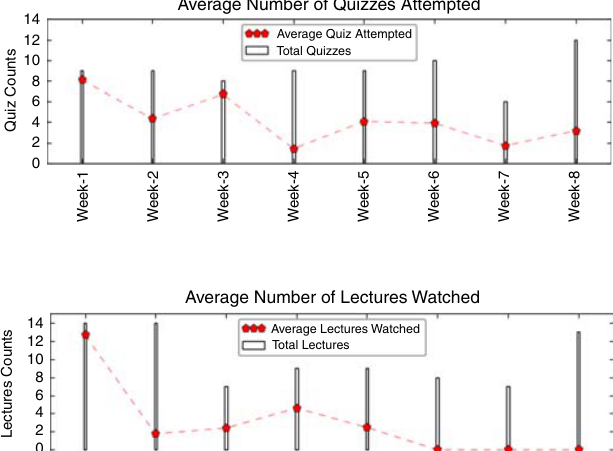
Figure 6. Average number of